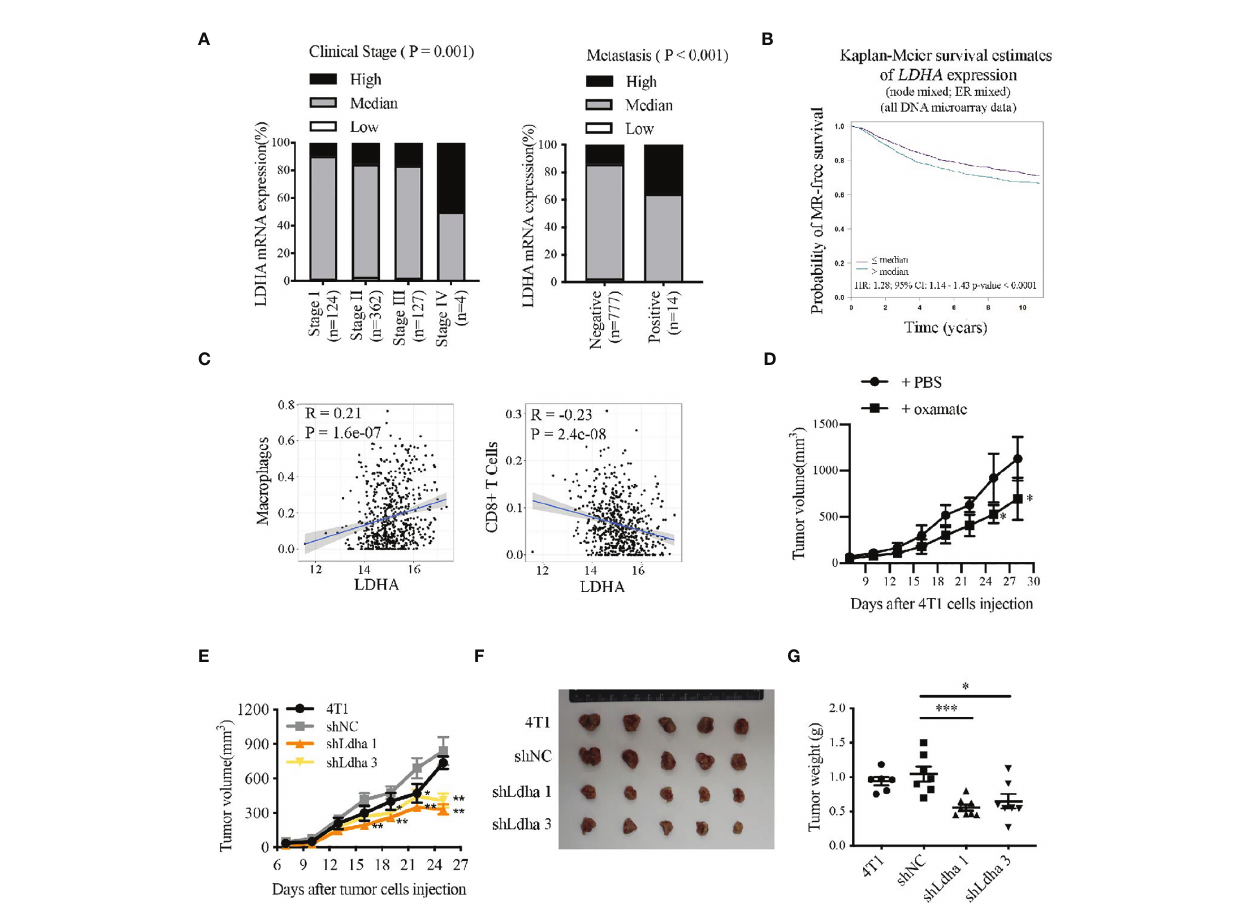
FIGURE 1 | LDHA predicted progression and prognosis of breast cancer patients, correlated with immunocytes in fi ltration in TME and promoted 4T1 tumor growth in mouse. (A) Proportion of patients depend on the LDHA expression in each clinical stage. Breast cancer samples were classi fi ed as high, medium, or low LDHA expression according to log2 (FPKM of LDHA). (B) Kaplan-Meier analysis of the overall survival of breast cancer patients with LDHA high or low expression. The analysis was performed by Breast Cancer Gene-Expression Miner v4.4 in Integrated Center for Oncology. (C) Bioinformatics analysis of the correlation between LDHA expression and in fi ltration of macrophages or CD8 T cells in breast cancer based on TCGA data set. (D) Tumor growth curve of mice inoculated with 4T1 cells treated with PBS (n = 4) or oxamate (n = 5). (E) Tumor growth curve of mice inoculated with 4T1 wild type, shNC or shLdha cells (n = 8 in each group). 1×10 5 cells were injected per mice. (F) Tumors were harvested on 25 th day after tumor cells inoculation and tumor picture was shown (n = 5). (G) Tumors weight were measured following tumor harvest (n = 8 in each group initially). * P < 0.05; ** P < 0.01; *** P <